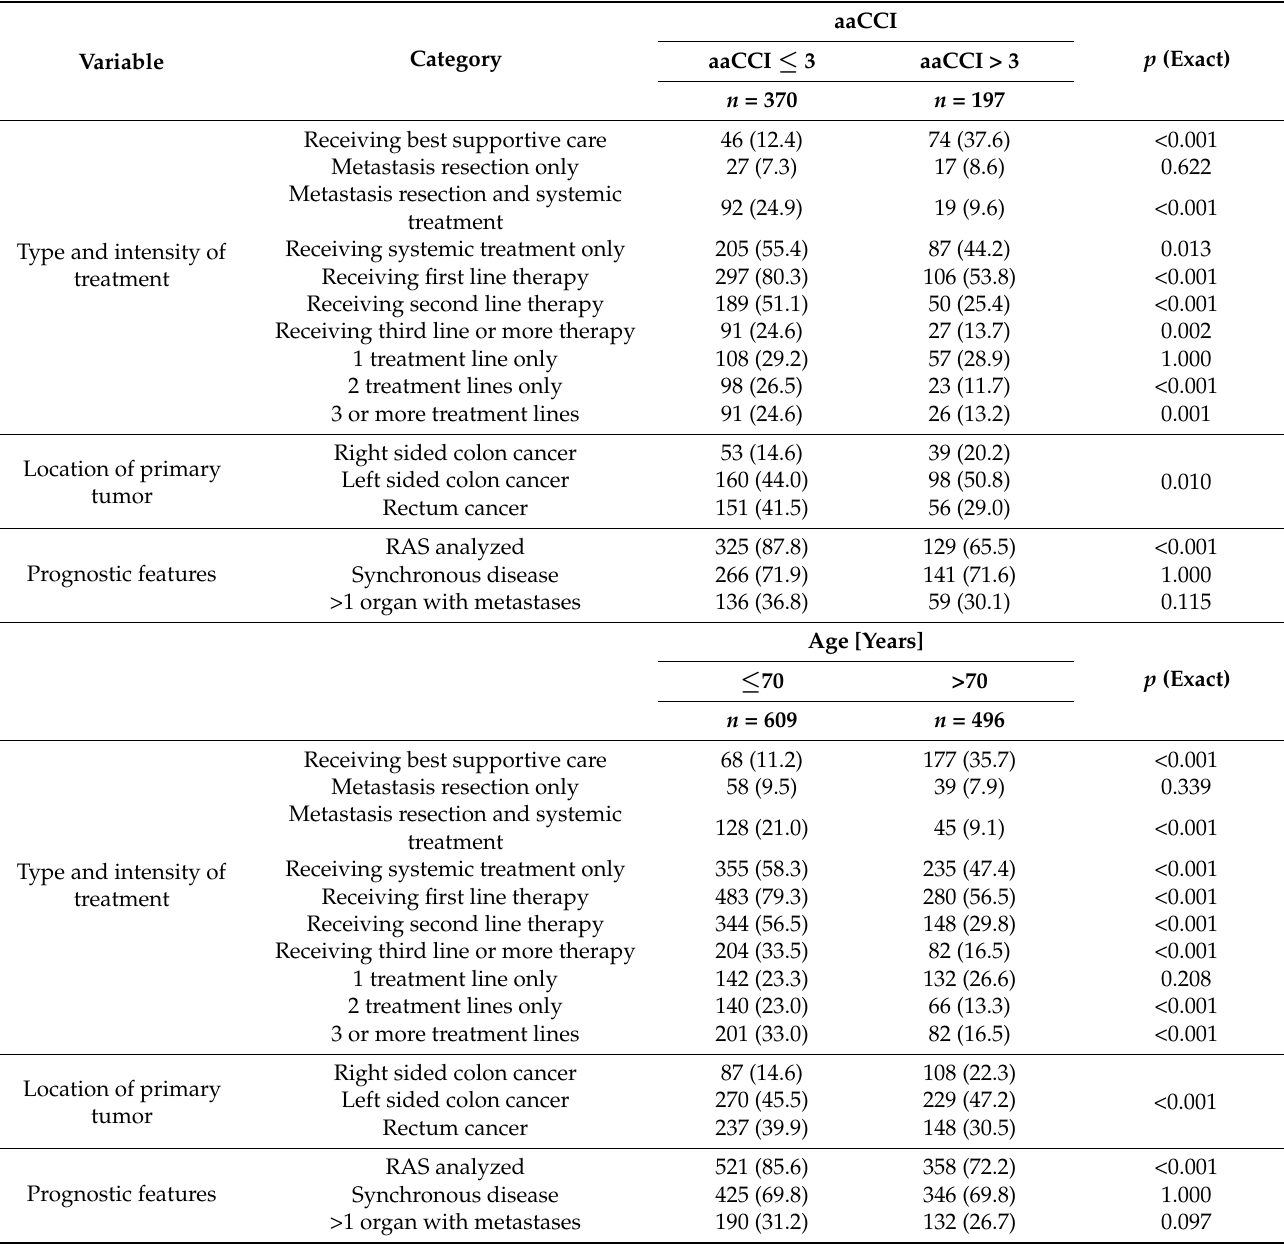
Table 3. Treatment intensity and biological features according to comorbidities and